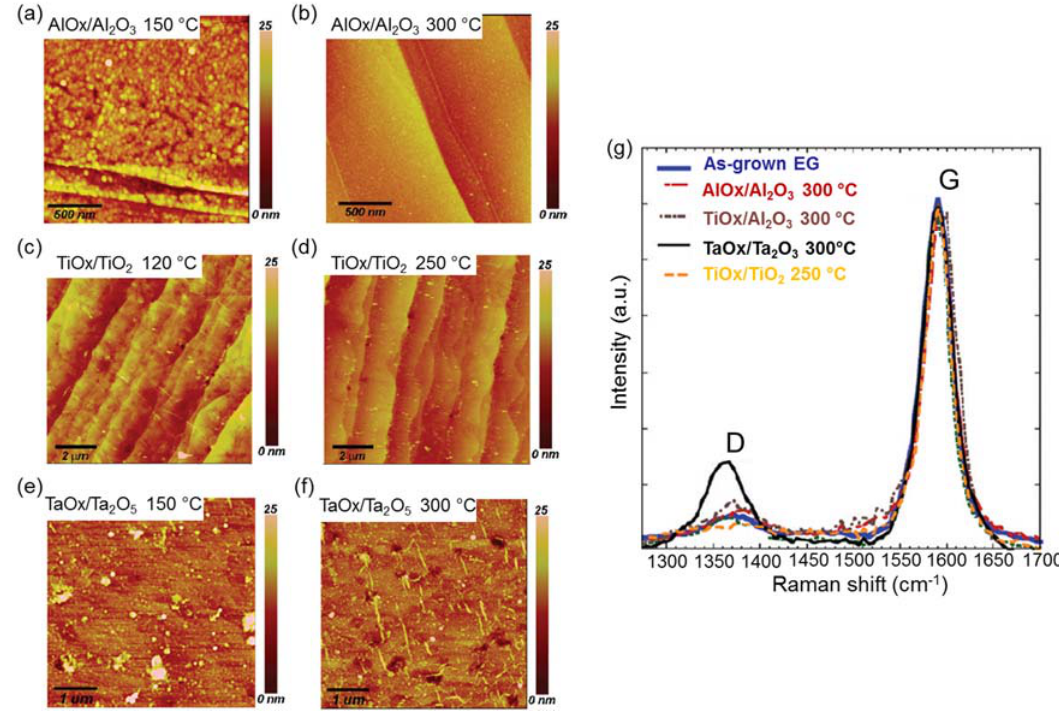
Figure 7. AFM morphology of Al 2 O 3 thin films grown by ALD at 150 ◦ C ( a ) and 300 ◦ C ( b ) on EG / SiC with an oxidized Al seed layer. Morphology of TiO 2 grown by ALD at 120 ◦ C ( c ) and 250 ◦ C ( d ) on EG / SiC with an oxidized Ti seed layer. Morphology of Ta 2 O 5 grown by ALD at 150 ◦ C ( e ) and 300 ◦ C ( f ) on EG / SiC with an oxidized Ta seed layer. ( g ) Raman spectra of as-grown EG and after ALD deposition of Al 2 O 3 , TiO 2 and Ta 2 O 5 with di ff erent seed layers. Al 2 O 3 and TiO 2 deposition introduces only a small amount of disorder in EG, whereas Ta 2 O 5 deposition appears to significantly degrade the quality of the underlying EG. Images adapted with permission from Ref. [34], Copyright American Chemical Society 2010.